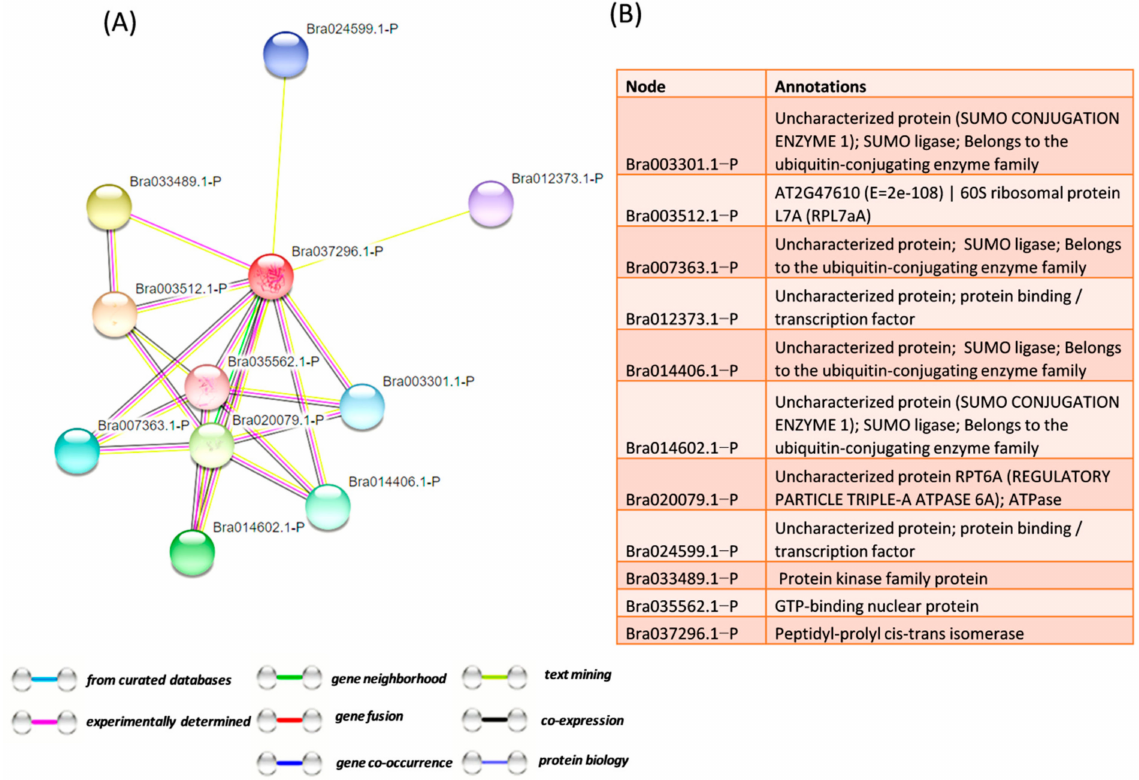
Figure 6. Interaction study using STRING software: ( A ) Protein-Protein Interaction network using default parameters and ( B ) Interacting proteins with annotation. Stronger associations are represented by thick